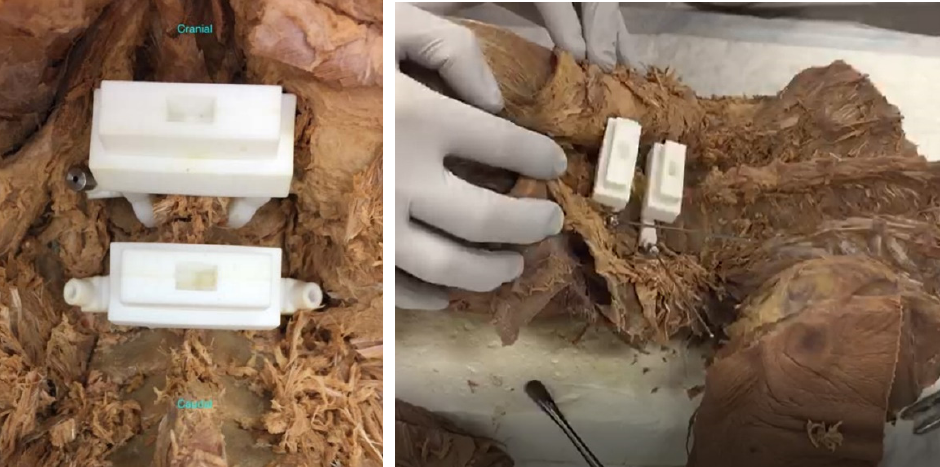
Figure 4. Photos of the cadaveric experimental set-up to test the accuracy of the click-on pedicle guides.